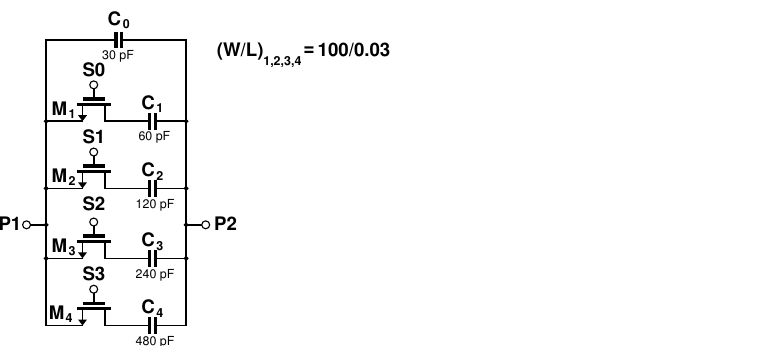
Figure 10. Waveforms from SPECTRE simulation.